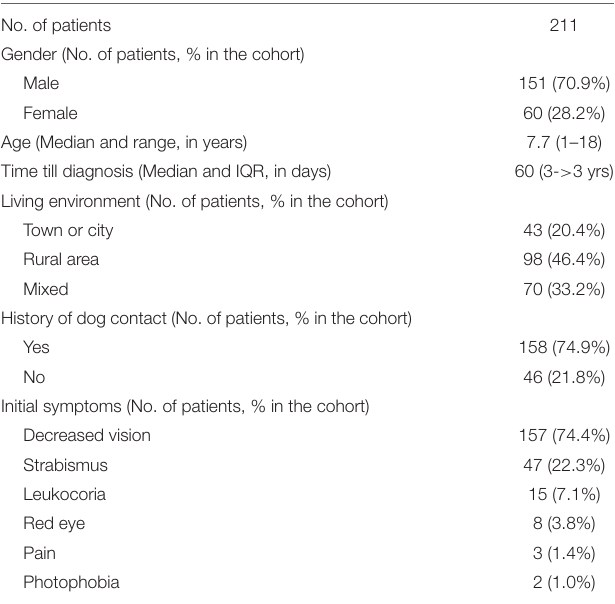
TABLE 1 | Demographic information and initial